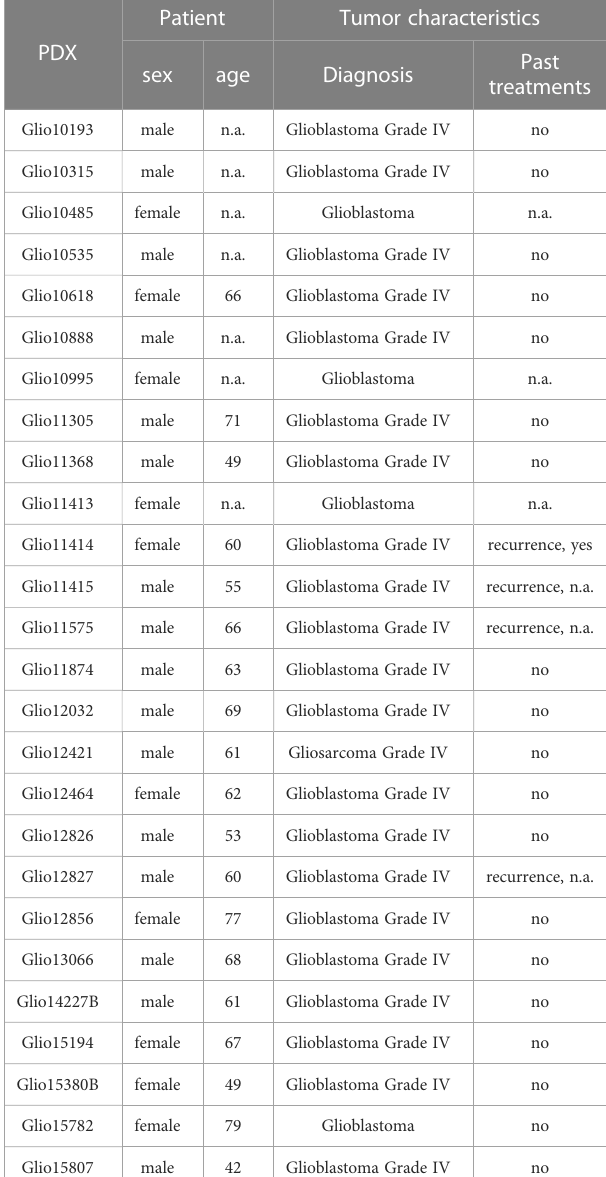
TABLE 1 Clinical characteristics of patients that provided tumor tissue of subcutaneously established and chemosensitivity-tested PDX models.